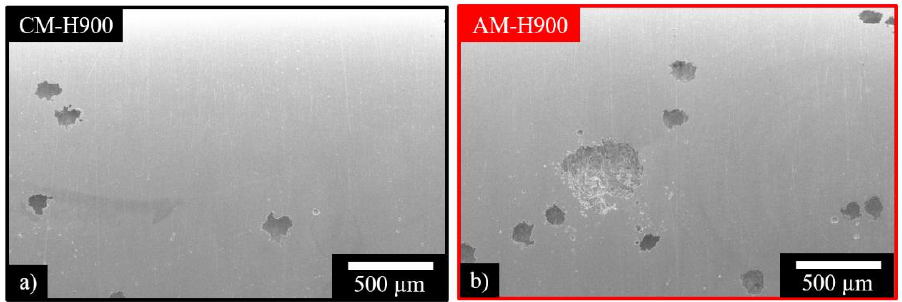
Figure 8. SEM observation of pits for: ( a ) CM; ( b ) AM samples. Pits were observed on the gauge length for samples polarised during the EAC tests.